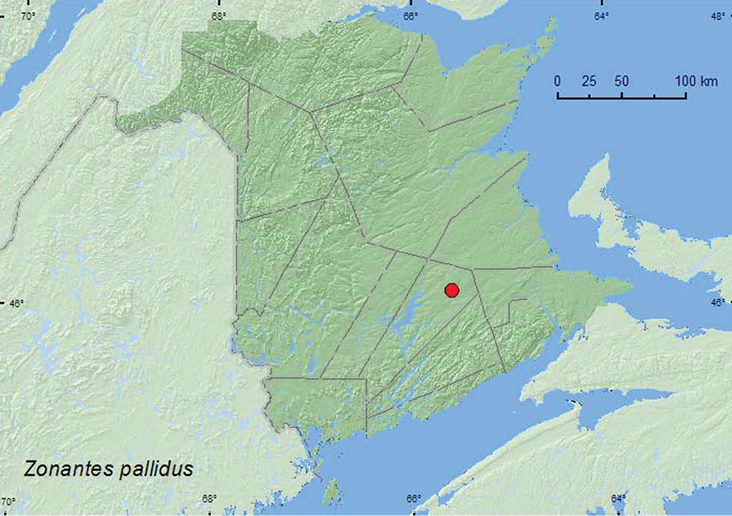
Collection localities in New Brunswick, Canada of Zonantes pallidus.